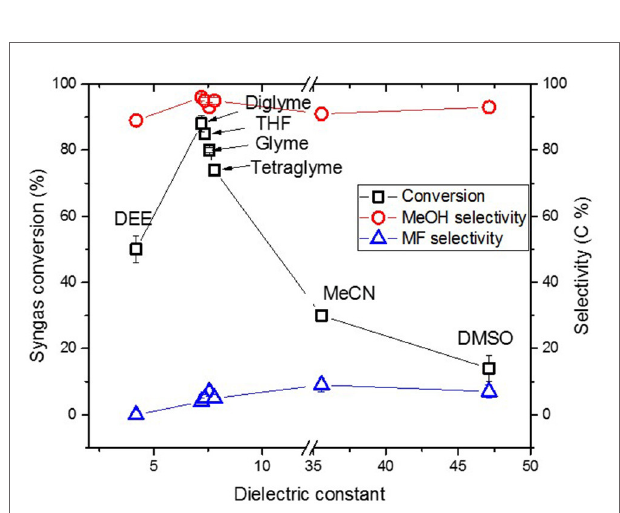
FigUre 4 | Syngas conversion and selectivity versus dielectric constant of solvent in the “once through” Cu nanoparticles catalyzed reaction.